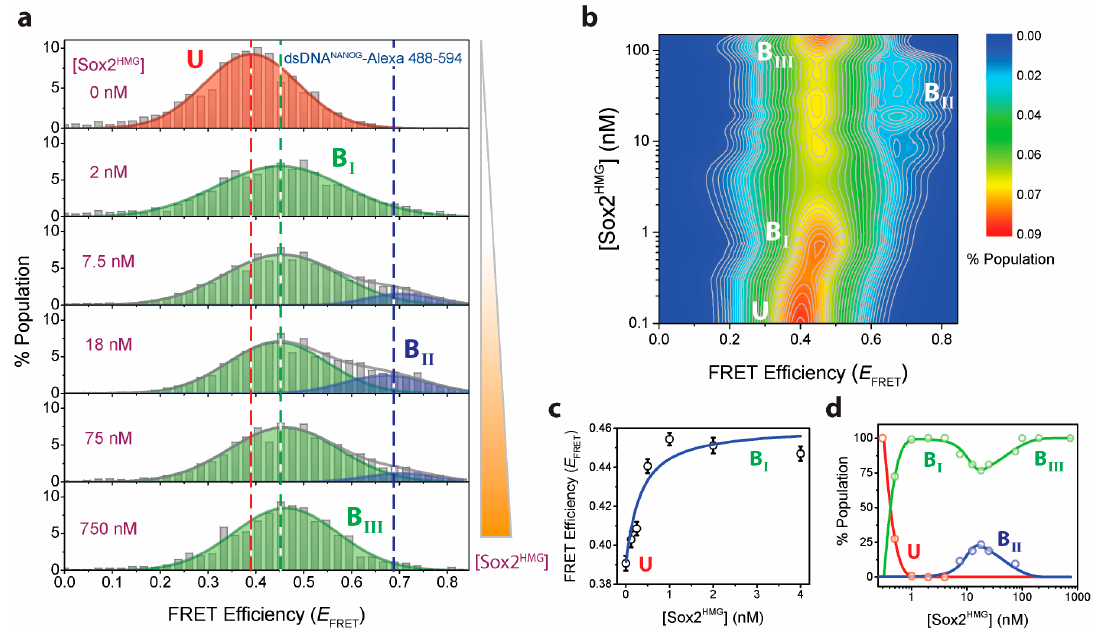
Figure 2. smFRET reveals Sox2 HMG concentration-dependent multistep bending of DNA NANOG . ( a ) E FRET histograms of DNA NANOG with increasing [Sox2 HMG ]. ( b ) [Sox2 HMG ]- E FRET contour map color coded based on fractional occupancy of individual DNA conformations. Corresponding DNA conformations are marked on the contour map. ( c ) Sox2 binding isotherm of the U ⇋ B I transition as probed by detecting changes in E FRET , linked to dsDNA bending transition. The NLS-derived apparent K D for this binding step is 0.30 ( ± 0.04) nM (binding equation with fixed Hill coefficient of 1). ( d ) dsDNA NANOG conformational distributions as modulated by Sox2 HMG concentration, determined from NLS fitting of individual smFRET histograms to Gaussian functions.